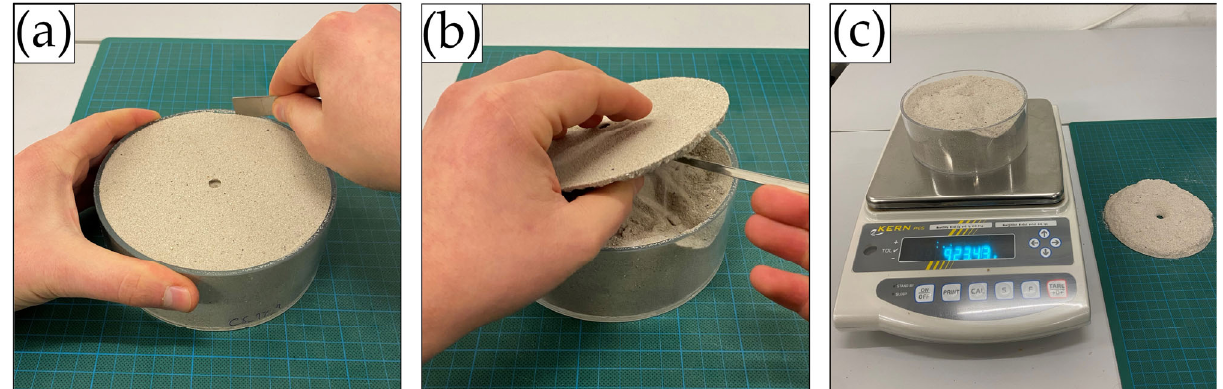
Figure 4. Process of removing the crust from the sample. ( a ) Loosening of the crust with a spatula from the mould rim, ( b ) removal of the crust with a spatula, ( c ) weighing of the sample without the crust.